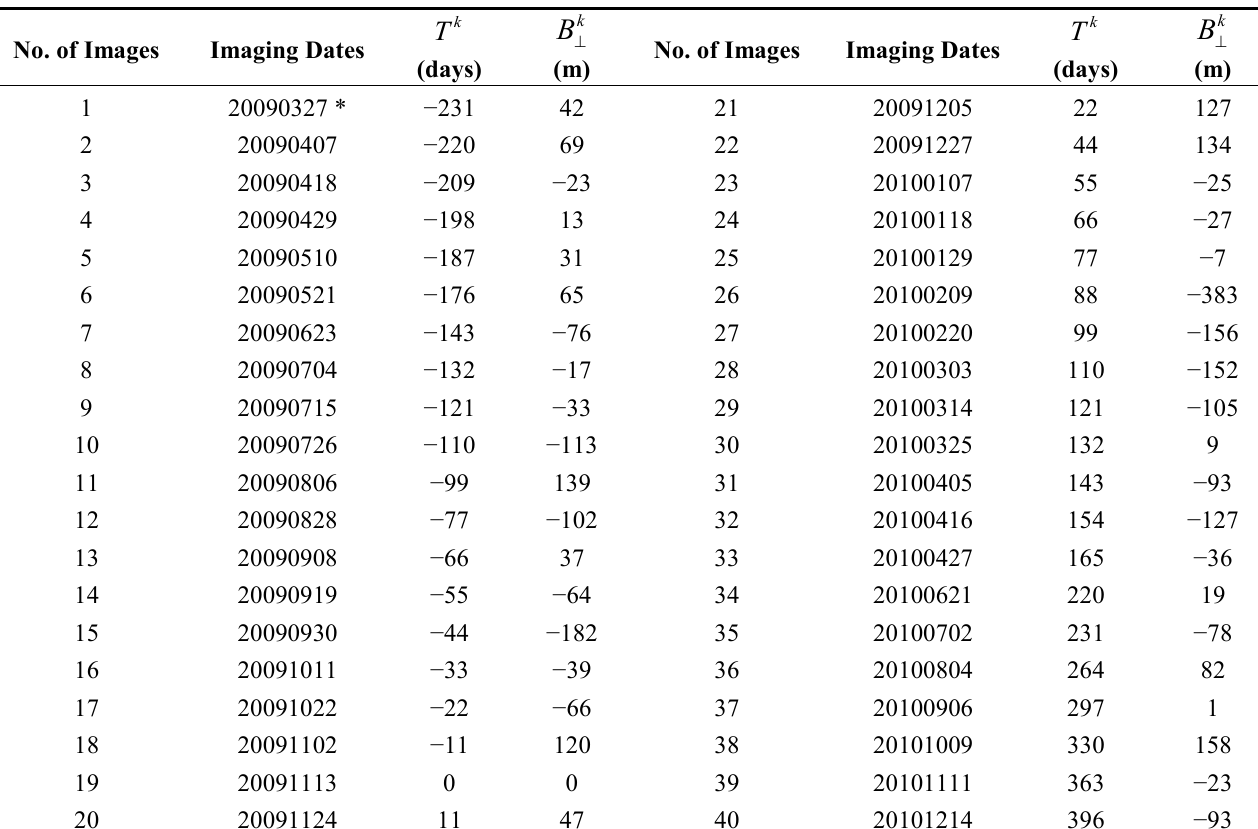
Table 1. The 40 TerraSAR-X (TSX) images and the interferometric parameters used in this